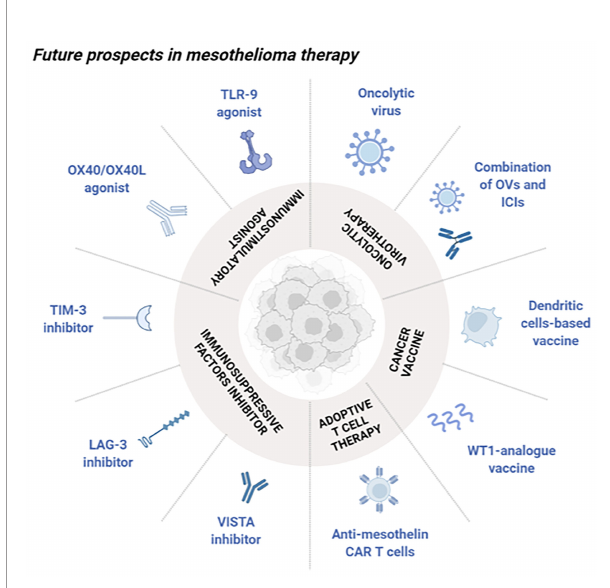
FIGURE 1 | Schematic overview of future perspectives in mesothelioma immunotherapy. Novel approaches under investigation aimed at stimulating the immune system in the treatment of mesothelioma can be divided into different classes. Oncolytic virotherapy, alone or in combination with ICIs, can selectively kill cancer cells as well as boosting a strong antitumor immune reaction. Cancer vaccines are classi fi ed into cell-based vaccines with the purpose of activating effector T cells, and antigen peptides preparation (WT1-analogue vaccine) which selectively stimulates the immune system. Adoptive T cell therapy presenting anti-mesothelin CAR are mainly used for their ability to speci fi cally recognize exposed tumor antigens. Immunosuppressive factors inhibitors such as VISTA, LAG-3 and TIM-3 inhibitors can block these molecules, known for their involvement into the tumor immune silencing. Immunostimulatory agents as OX40/OX40L and TLR9 agonists can boost a selectively immune reaction towards the tumor microenvironment. Created with